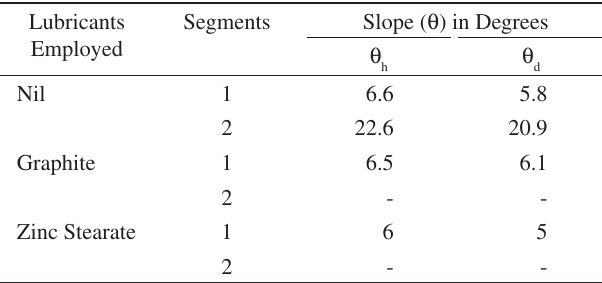
Table 3. Strain hardening co-efficient of flow curves.